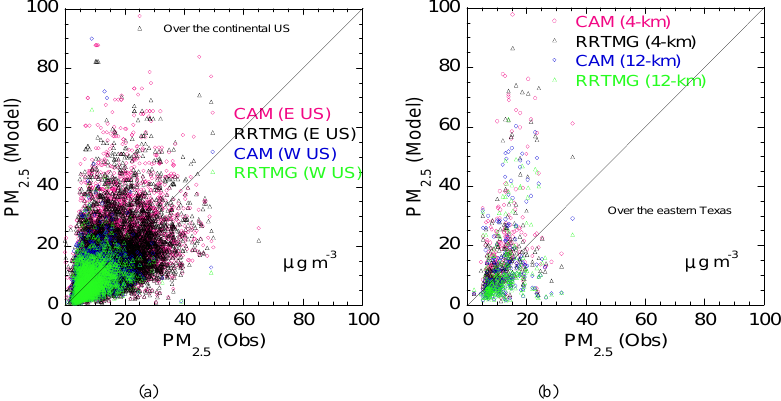
Figure 5. Scatter plots of the modeled (CAM (WRF-CMAQ/CAM) and RRTMG (WRF-CMAQ/RRTMG)) and observed daily PM 2.5 concentrations at the AIRNow monitoring sites (a) over the continental U.S.(12-km resolution model grid); (b) over eastern Texas from the simulations at 4-km and the 12-km resolution model grids